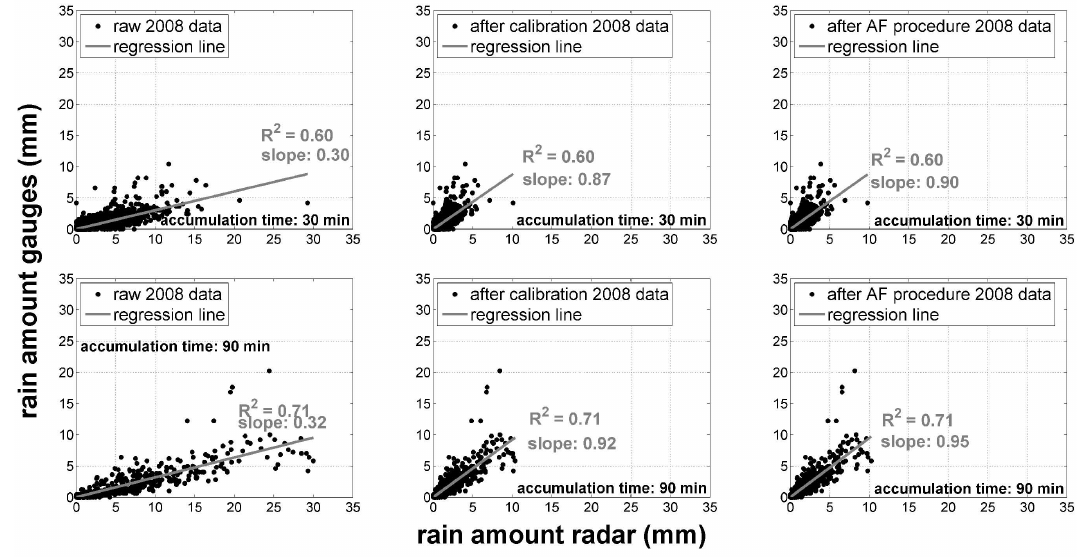
Fig. 13. Scatter plots of rainfall time series’ pairs, obtained during 2008 by Polar 55C and by each rain gauge located from 25 to 40km away from Polar 55C. These refer to a time aggregation of 30 and 90 min (upper panels and lower panels, respectively) for the initial data sets (left panels), after calibration (middle panels) and after the adjustment procedure (right